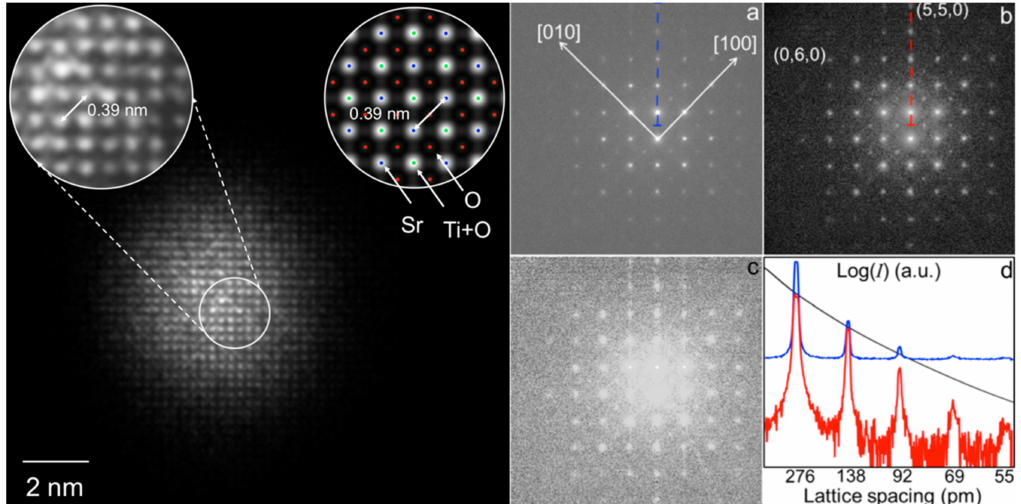
Figure 3. Left- HRTEM image of a nano-region of a SrTiO 3 extended sample in [001] zone axis, with a zoom in the left inset, and the relevant simulation in the right inset (objective lens underfocus of 41.3 nm and specimen thickness of 25.0 nm); the dots in the simulation point to the structural positions of the SrTiO 3 atomic species in [001] projection: Sr = Blue, Ti+O = green, O = red. ( a ) KEDI raw experimental nano-diffraction pattern (logarithmic scale); ( b ) sup{ I ( s )} rescaled pattern; ( c ) difference between patterns shown in ( a , b ); ( d ) comparison in a logarithmic scale between the line profile along the dashed blue line in ( a ) (blue curve) and along the dashed red line in ( b ) (red curve) after rescaling. Black curve is the corresponding profile of sup{ I ( s )} × I max constraint. (Reprinted with permission from De Caro et al.